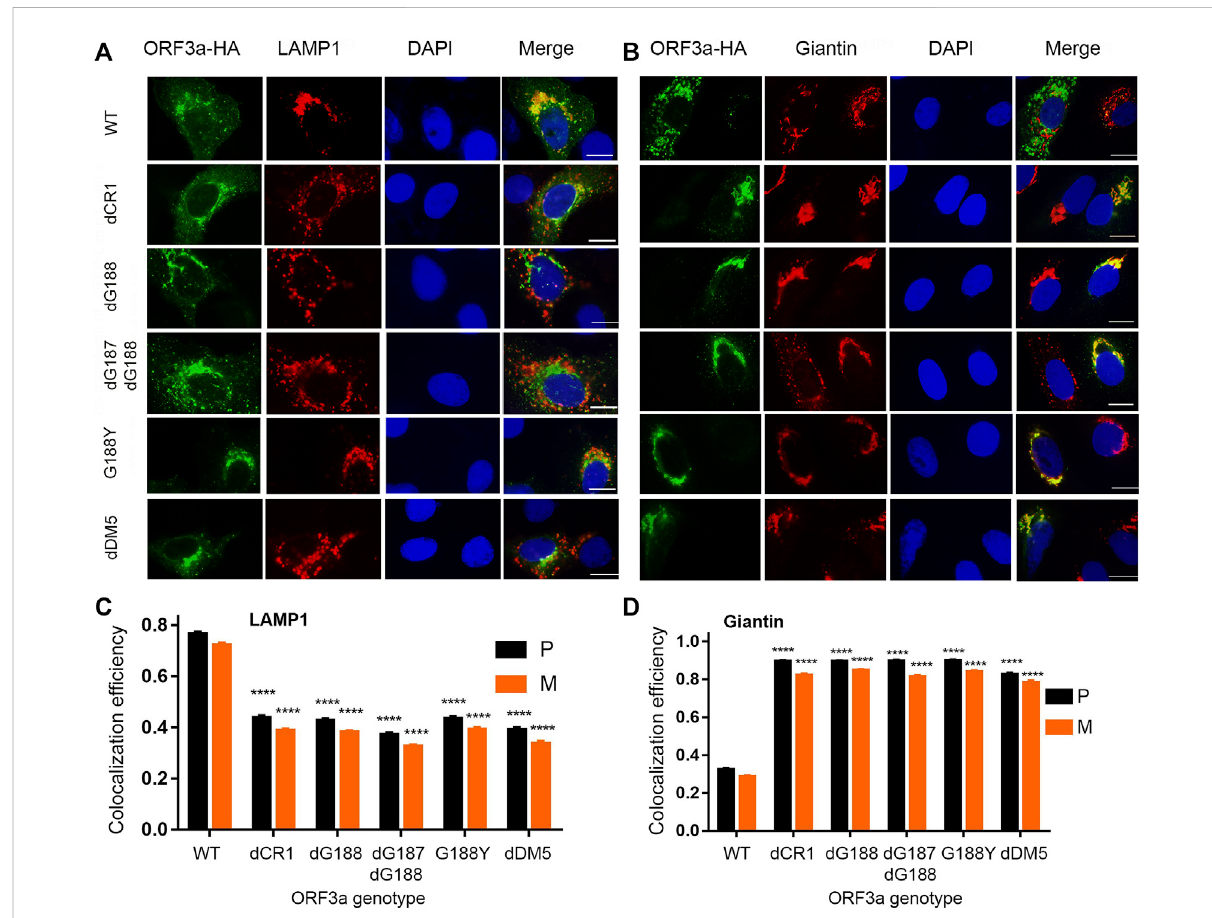
FIGURE 3 Interruption of any diG residues of ORF3a results in signi fi cant Golgi retention like deletion of the YXX Φ motif. Four diG-related ORF3a mutants were tested with the WT ORF3a and an YXX Φ motif mutant (dDM5) as controls. The four diG-related mutants include a deletion mutant of dCR1 (d175-194)thatspansthediGmotifanddeletestheC-terminalendofthe β 4sheetandN-terminalendofthe β 5sheet,deletionsofasingleGresidue (dG188) and both residues (dG187/dG188) as well as a single aa transition from glycine to tyrosine at the residue of 188 (G188Y). (A) Showing diminished association of the diG-related and YXX Φ motif mutant ORF3a from lysosomes, that were shown in red by anti-LAMP-1. (B) Showing the same diG-related and the YXX Φ motif mutations as in (A) resulted in increased presence in the Golgi apparatus. The Golgi apparatus was detected using anti-Giantin antibody as shown in red. Quanti fi cation of co-localization of WT or mutated ORF3a with lysosome (C) or Golgi apparatus (D) by using the same method as described in Figure